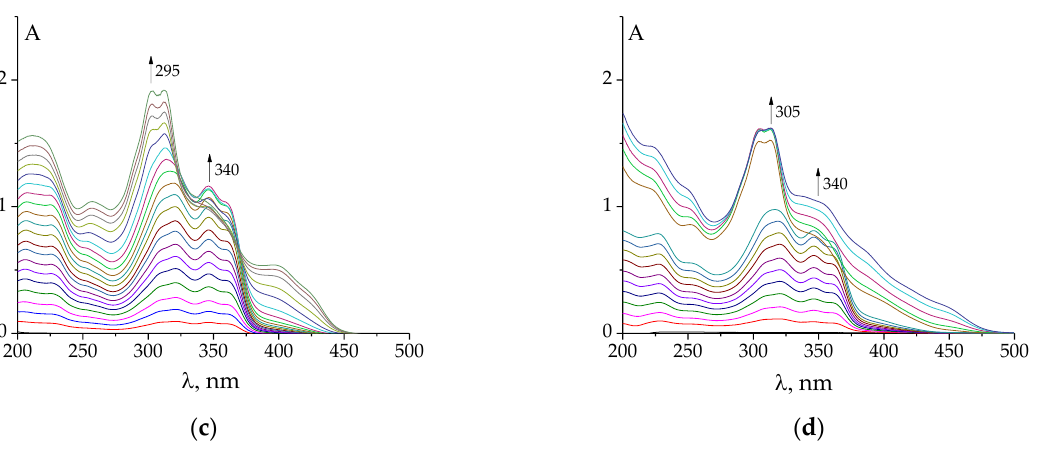
Figure 3. Examples of changes in UV–Vis spectra of HAuCl 4 ( a , c ) and HClO 4 ( b , d ) after the addition of PLP-F2H ( a , c ), PLP-T2H ( b , d ). Titrant: C(AuCl 4 − ) = 2·10 −4 mol L −1 ; C(H + ) = 5·10 −4 mol L −1 ( a , c ); C(H + ) = 5·10 −4 mol L −1 ( b , d ). Titrant: C( PLP-F2H ) = 1.5·10 −3 mol L −1 ; C(OH − ) = 0.01074 mol L −1 ( a , c ); Titrant: C( PLP-T2H ) = 1.5·10 −3 mol L −1 ; C(OH − ) = 0.01074 mol L −1 ( b , d ) . Twenty additions of 10 μL volume .